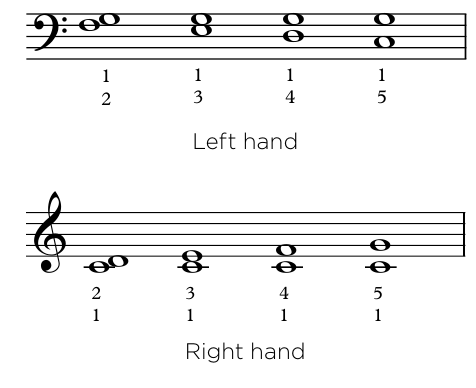
FIGURE 2 | Harmonic intervals in simple